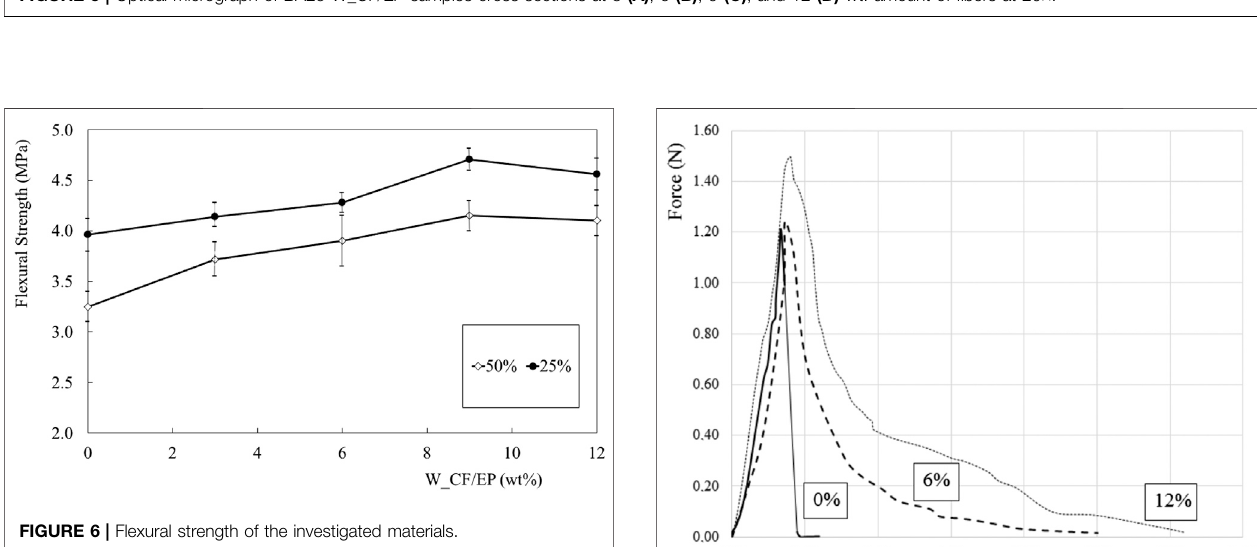
FIGURE 5 | Optical micrograph of BA25-W_CF/EP samples cross sections at 3 (A) , 6 (B) , 9 (C) , and 12 (D) wt. amount of fi bers at 20 × .